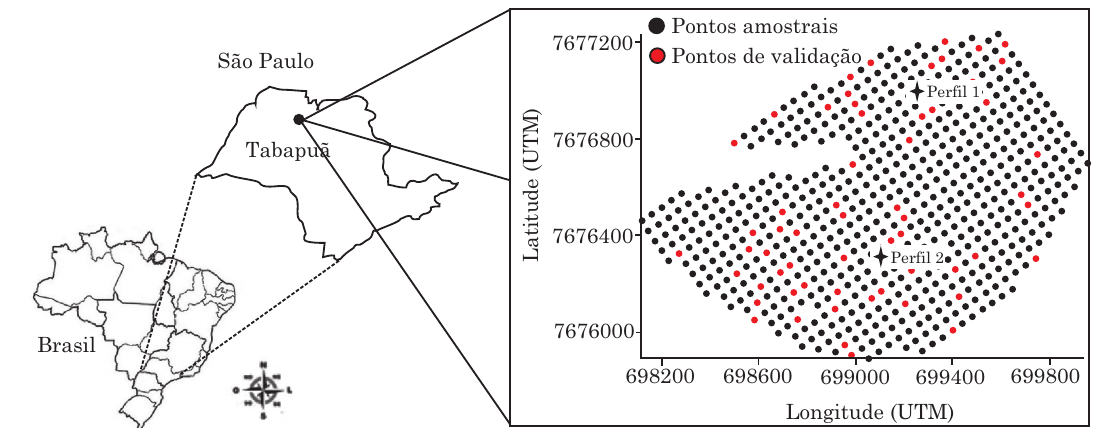
Figura 1. Localização da área experimental e mapa de distribuição dos pontos observados.